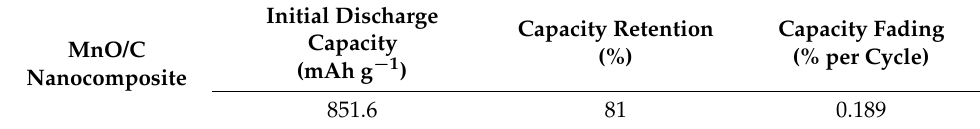
Table 2. The summary of the electrochemical performance of the MOF-derived MnO/C hybrid structure.